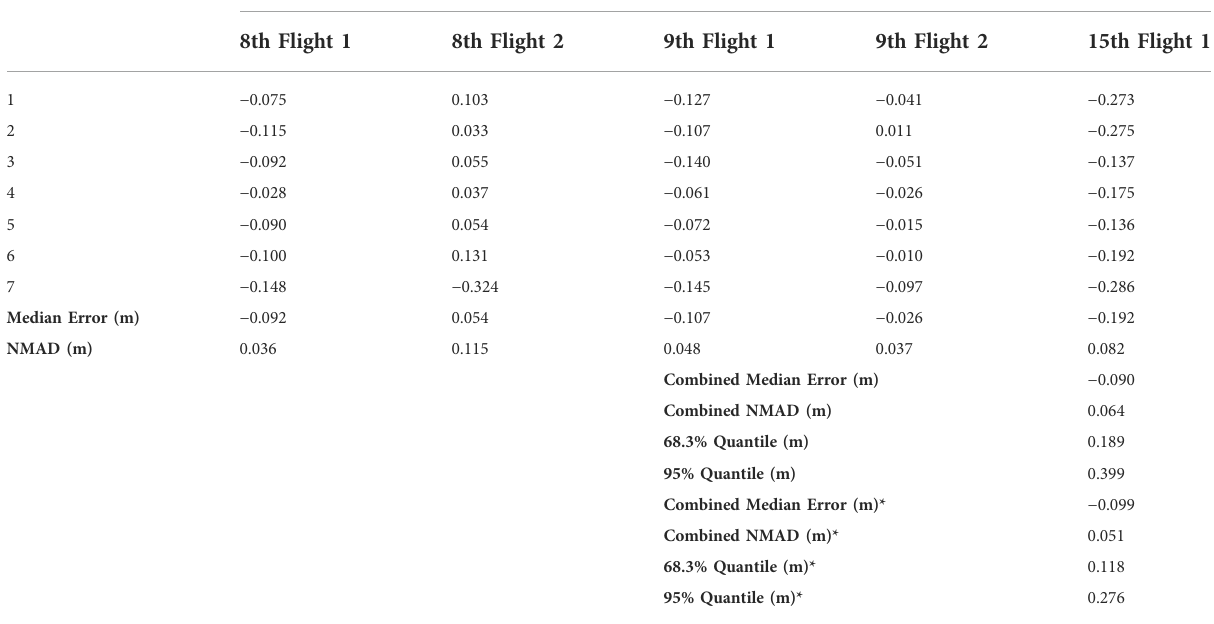
TABLE 3 Results of the accuracy assessment comparing each survey to Ground Control Points (GCPs) placed over stable ground adjacent to the glacier.Thesewereusedtoassesstheaccuracyofeachsurveyperday,andtheoverallaccuracyofthesurveyscombined.Valuesmarkedwithan* representstatisticswherebyvaluesforF2onthe8thhavebeenremoved,duetotherandomerrorintroducedthroughoutthesurveythatisdiscussed in